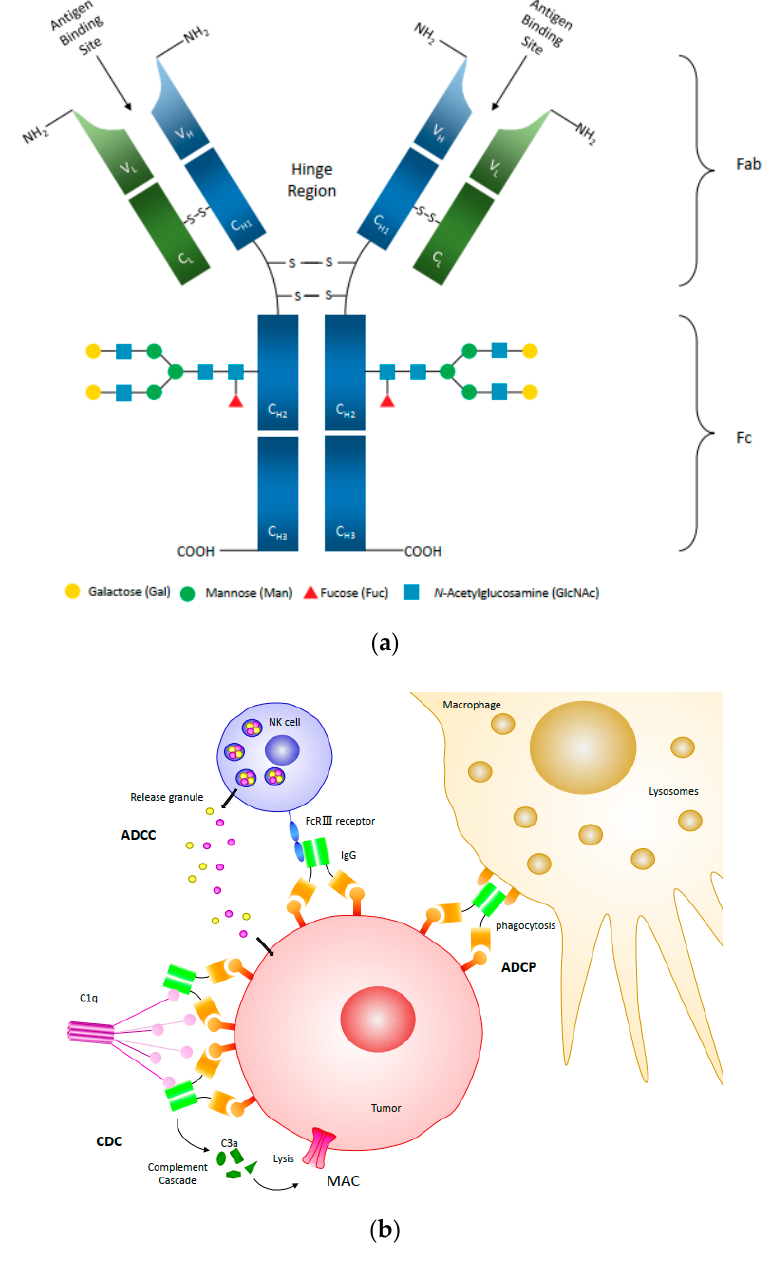
Figure 1. ( a ) The illustration of human IgG 1 structure with N-glycan attached at Asn297 site in the CH2 of the Fc region. Light chains (L) are highlighted in green, and heavy chains (H) are